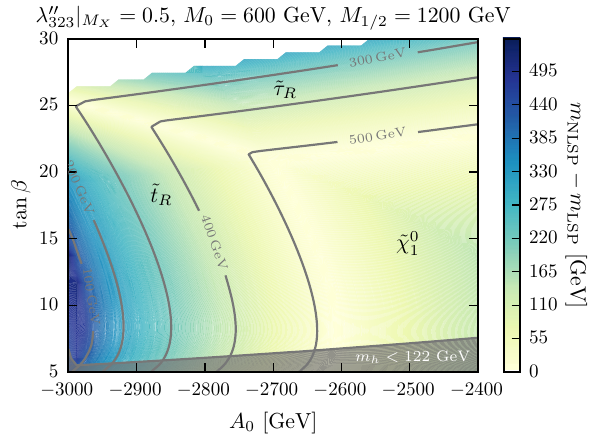
Fig. 5 Regions in the A 0 –tan β plane with different LSPs for λ (cid:4)(cid:4) | = 0 . 5. The other parameters are M M X 323 1 . 2 TeV. In the top left white region the staus become tachyonic. As in Fig. 4, the neutralino and gluino masses do not vary significantly as M 1 / 2 is fixed. Their masses are m ˜ χ 0 The other labels are as in Fig. 3